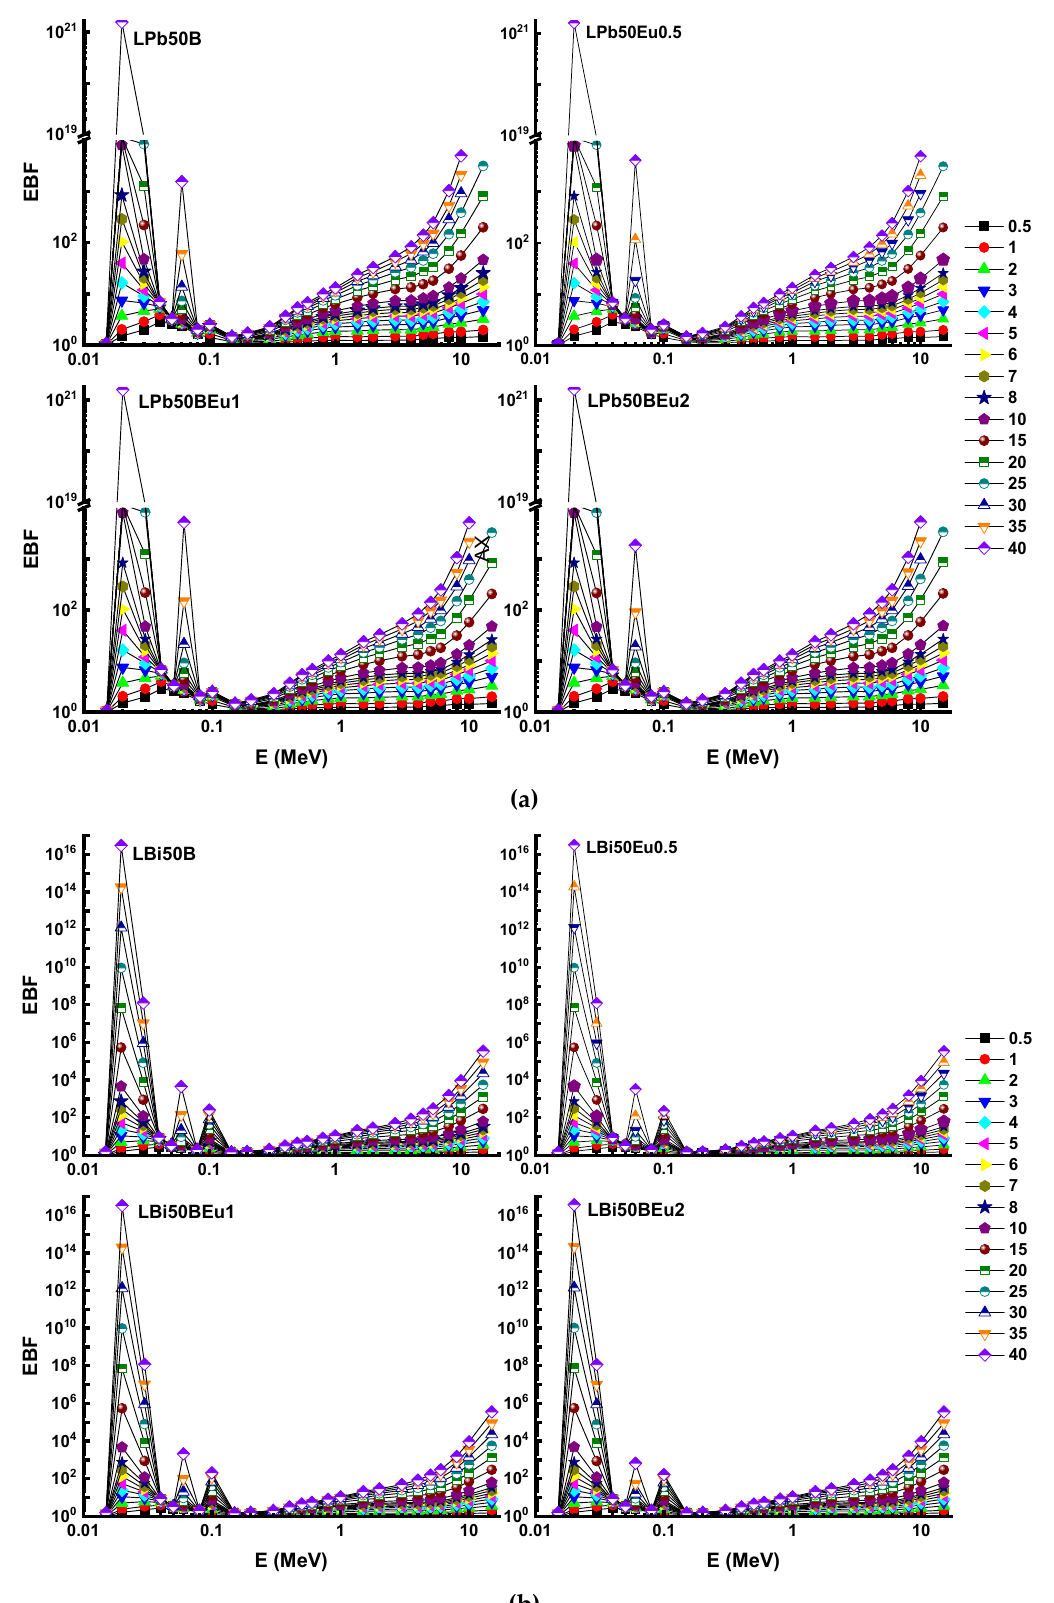
Figure 7. Variation of exposure build-up factor (EBF) against photon energy for ( a ) LPb50BEu and ( b ) LBi50BEu glasses.